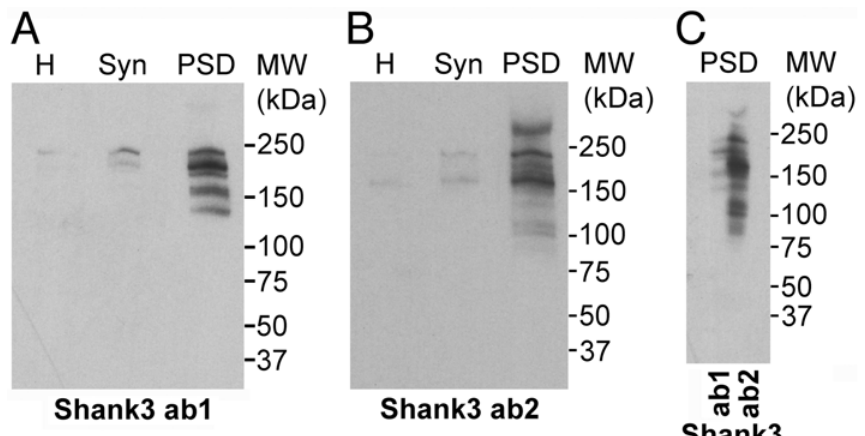
Fig 2. (A, B) Western immunoblots with two antibodies for Shank3 (ab1 and ab2) comparing homogenate (H), synaptosome (Syn), and PSD fractions from cerebral cortex of rat show significant enrichment of Shank3 in the PSD fraction. Ten micrograms of protein was loaded into each lane for the homogenate and synaptosome, and five micrograms of protein was loaded for the PSD fraction. (C) Western immunoblots with the two Shank3 antibodies reveal a common set of bands in the PSD fraction. After transfer, the membrane was cut in the middle of the lane to separately probe with the two antibodies.